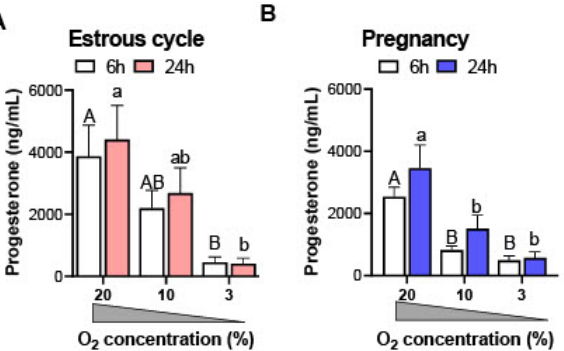
Figure 1. The concentration of progesterone in media samples collected after incubation of luteal tissue obtained from cyclic (day 13 of the estrous cycle; ( A )) and early pregnant gilts (day 13 of pregnancy; ( B )) in different concentrations of O 2 (20, 10, and 3% O 2 ) for 6 and 24 h. Data are presented as mean ± SEM ( n = 5–7 per reproductive status). The analysis was performed using a two-way ANOVA with Bonferroni post-hoc test. Capital and small letters reflect significant differences between different concentrations of O 2 for 6 and 24 h incubations, respectively.